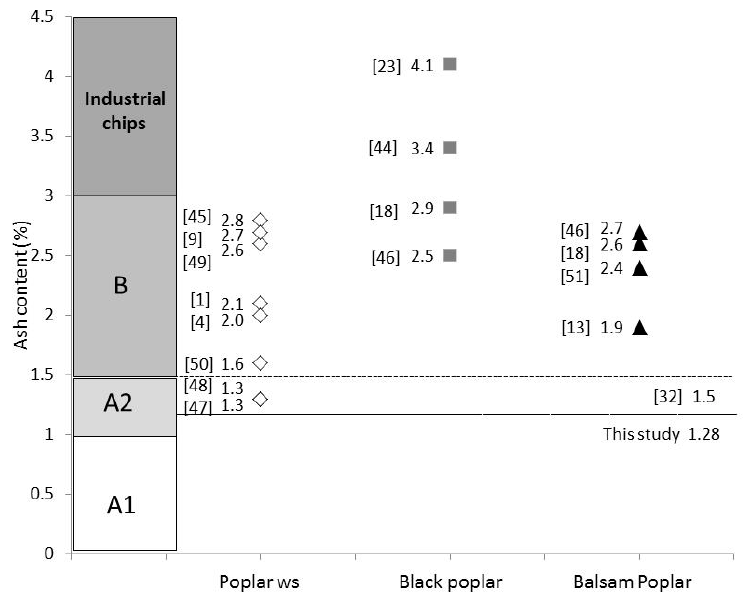
Figure 8. Values of ash content (%) found by several authors for different poplar genotypes. ◊ represents poplar without group speci fi cation (poplar ws); □ grey square represent the black poplar group and black triangle represent balsam poplars. The continued line represent the values of this study and the dotted line, the threshold for the A2 quality.